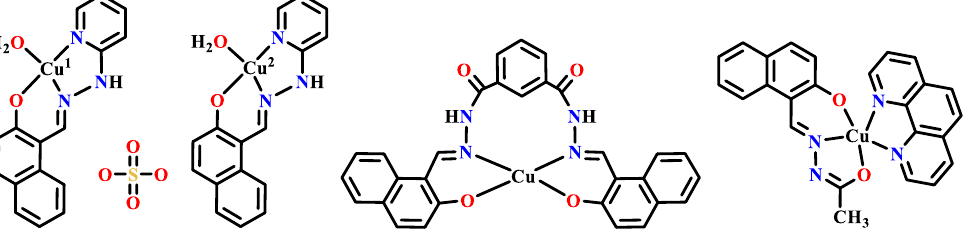
Figure 20. Several different types of Cu(II) complexes of 2-hydroxylnaphthylhydrazone ligands.